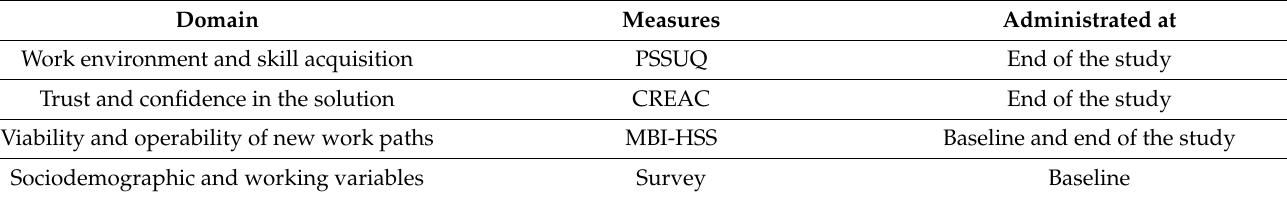
Table 4. Survey measures completed by health professionals.